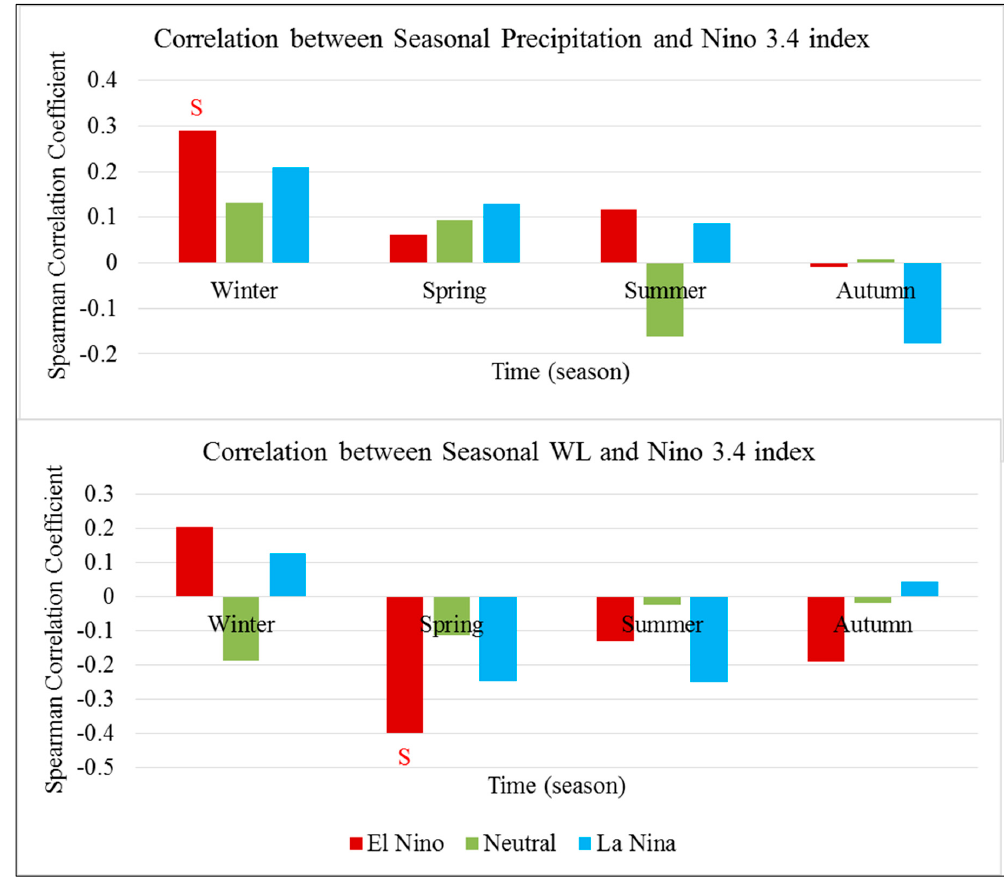
Figure 6. Spearman correlation coefficients between the El Niño Southern Oscillation (ENSO) phases and precipitation/WL at seasonal scale.